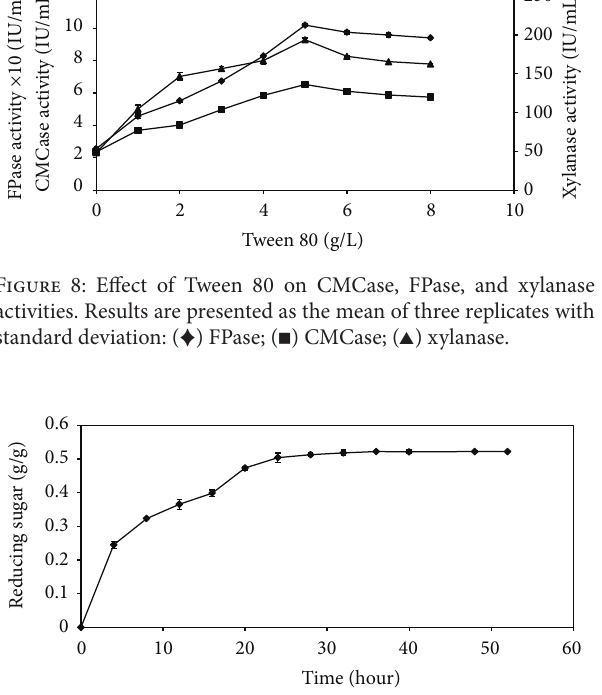
Figure 9: Enzymatic hydrolysis of alkali pretreated rice straw. Results are presented as the mean of three replicates with standard